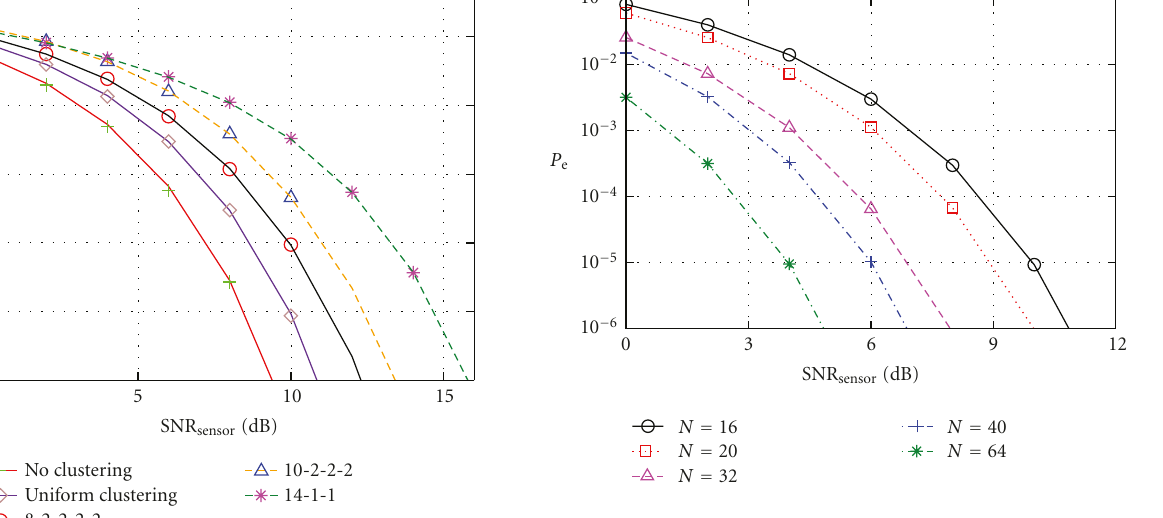
Figure 3: Probability of decision error, as a function of the sen- sor SNR, in a scenario with uniform clustering and equal a priori probabilities of the common binary phenomenon ( p 0 = p 1 = 1 / 2). Di ff erent values of the number of sensors are